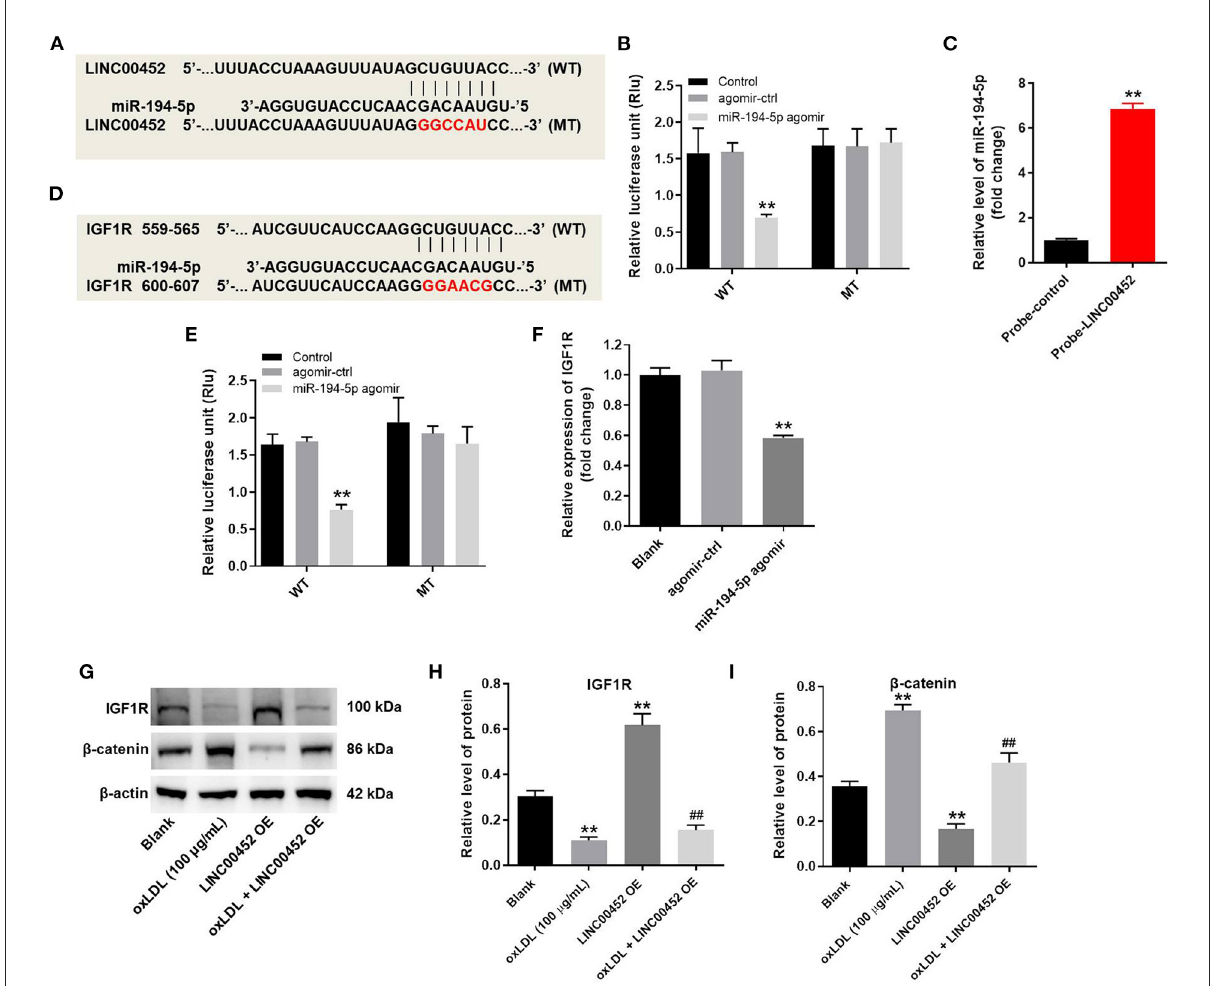
FIGURE4 LINC00452 can regulate miR-194-5p/IGF1R axis in HUVECs. HUVECs were treated with oxLDL (100 µ g/mL) for 24h. Next, HUVECs were transfected with pcDNA3.1-LINC00452, miR-194-5p agomir NC, or miR-194-5p agomir using Lipofectamine 2000 for 24h. (A)